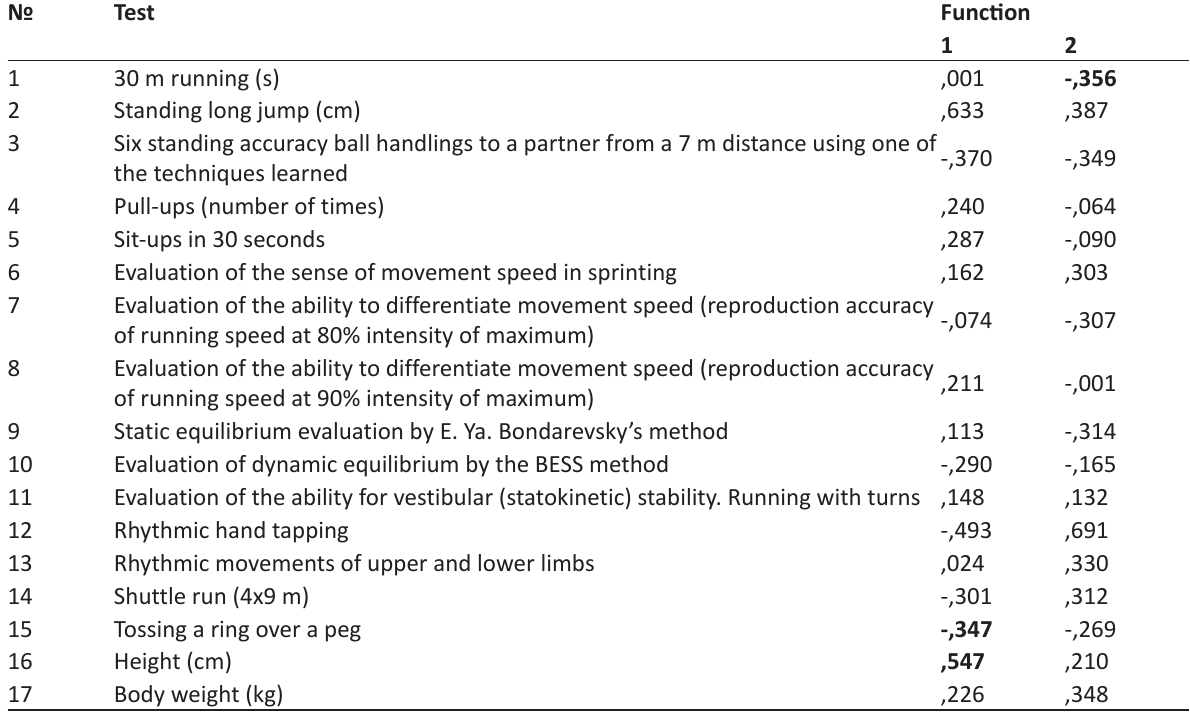
Table 3. Standardized Canonical Discriminant Function Coefficients. Boys aged 11-13 years old